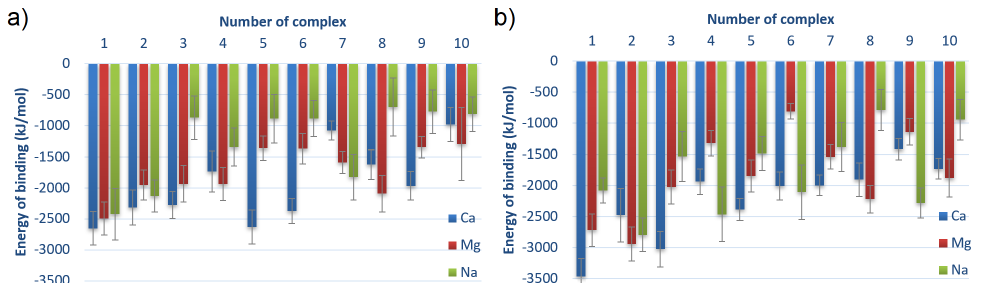
Figure 6. Averaged energy of binding for different complexes for ( a ) HSA:CS-6 and ( b ) HSA:CS-4. Complexes are sorted from lowest to highest averaged energy of binding after MD simulations; thus, the strongest bound are first (cf. Table 1). Error bars present doubled STD.